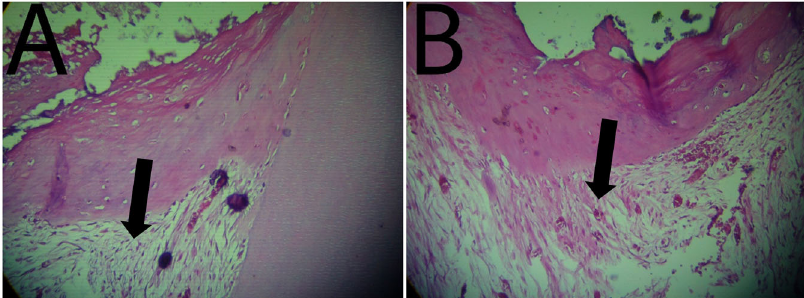
Fig. 2 The arrow points to soft tissue organization. A Photomicrograph of dental pulp capped with Portland Cement. B Photomicrograph of dental pulp capped with MTA.